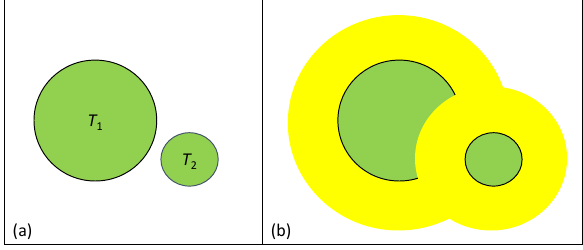
Figure 7. Case of non-connected territories. (a) A territory with two components. (b) With their outer crowns, each with the same width.